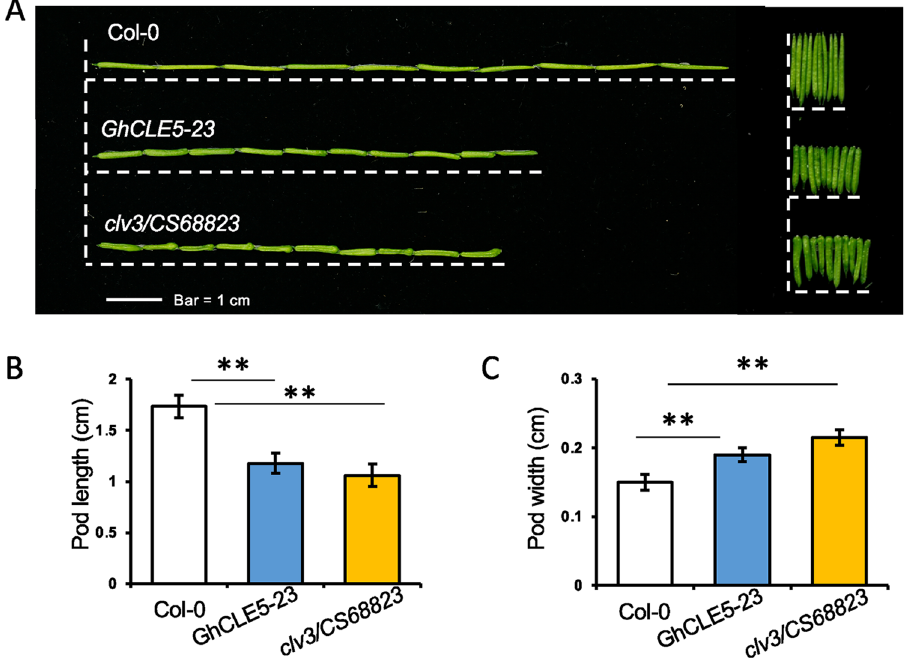
Figure 4. The phenotypes of GhCLE5 transgenic Arabidopsis siliques. ( A ) The photo images of the siliques. The histogram of the silique pod length ( B ) and width ( C ). N = 30. **, p < 0.01; Student’s t test. Error bar =